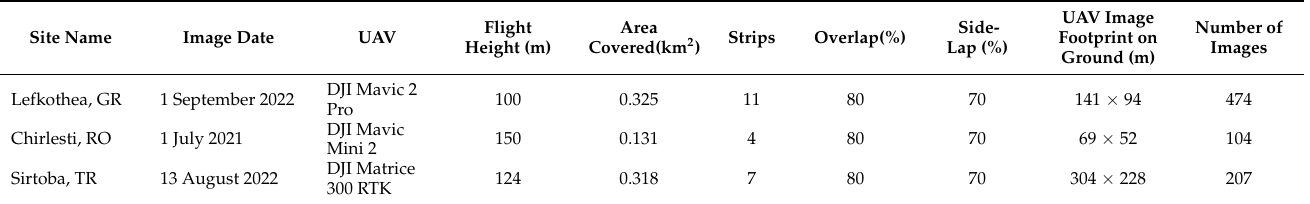
Table 1. Characteristics of the UAV surveys flown over Lefkothea in Greece, Chirlesti in Romania, and Sirtoba in